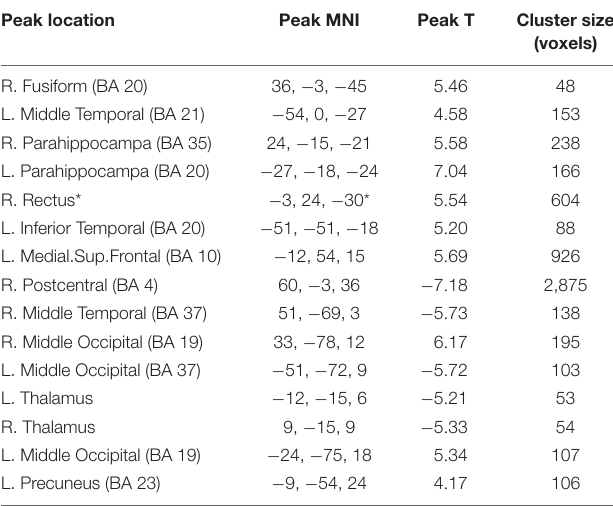
TABLE 1 | Location of peak voxels that showed significant difference between EC and EO condition using linear coefficient b. Peak